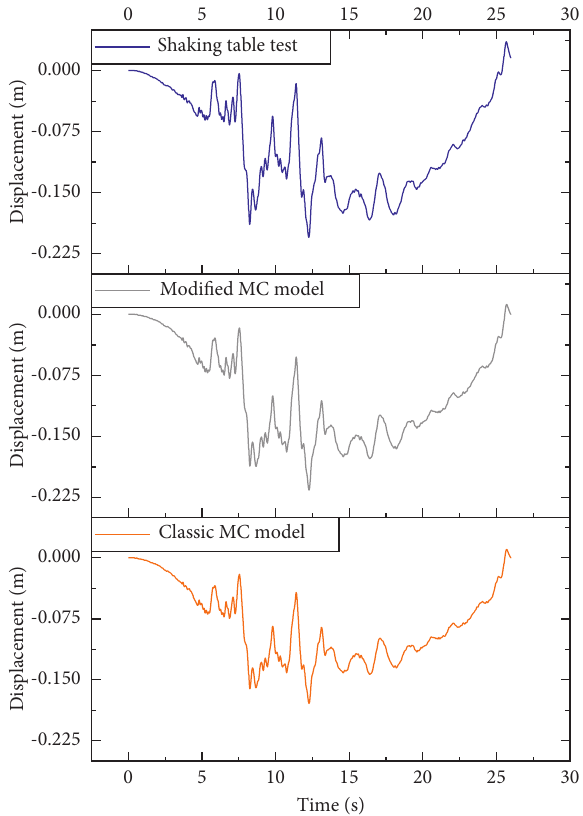
Figure 22: Displacement time history at point A5H.